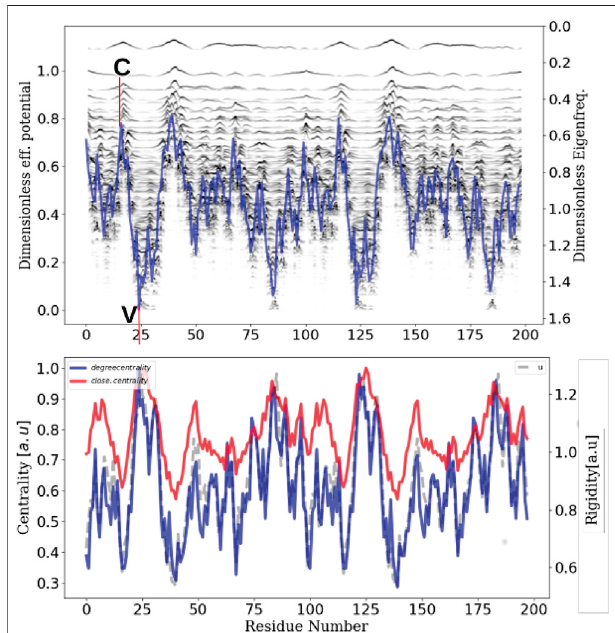
FIGURE 7 | Network centrality, rigidity and localization landscape The inherent ability of a protein structure to generate con fi ning potentials (top plot) – which in turn will de fi ne energy transport properties – is intrinsically linked to its rigidity (grey), which in turn can be seen as a modulation of connectivity or centrality (red and